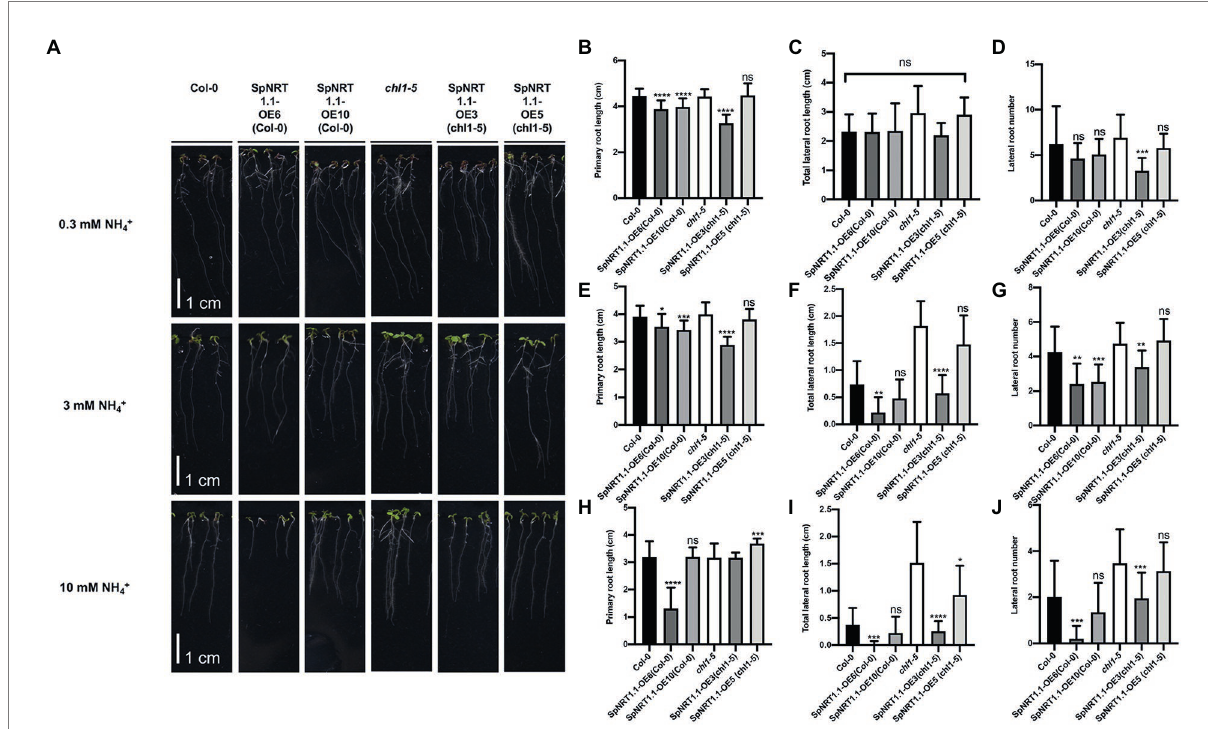
FIGURE 6 Overexpression of SpNRT1.1 in Col-0 and chl1-5 in Arabidopsis suppresses primary and lateral root growth under different ammonium concentrations. (A) Phenotype of SpNRT1.1 overexpressed lines and complementary lines under different ammonium-supplied concentrations. (B–J) Primary root length, lateral root number, and total lateral root length of SpNRT1.1 overexpressed and complementary plants under 0.3 mm NH 4+ -supplied condition (B–D) , 3 mm (E,F) , 10 mm (H–J) . Student’s t -test was used for significant difference analysis. Asterisks indicate significance levels compared with chl1-5 mutant plants, * p < 0.05, ** p < 0.01, *** p < 0.001, **** p < 0.0001, n ≥ 10, Scale bar = 1